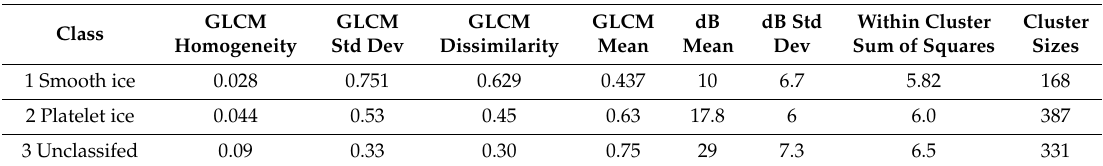
Table 2. Values of class cluster centers, within-cluster sum of squares and cluster sizes and data mean for each of the statistics generated.